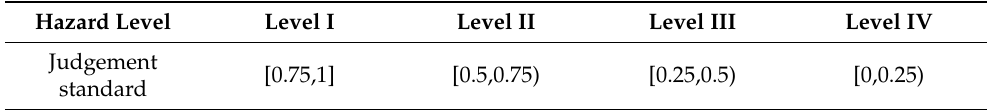
Table 1. Judging table of hazard